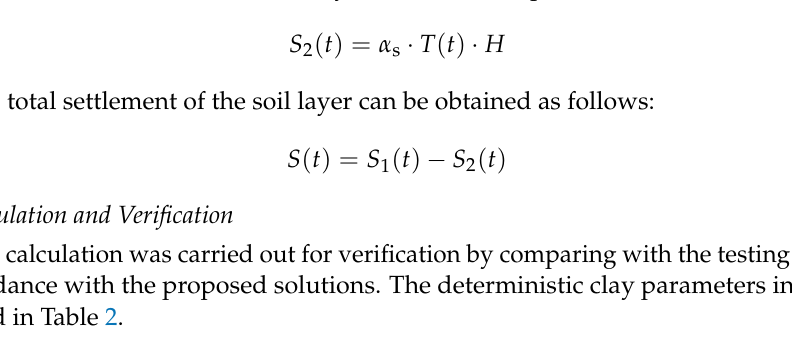
Table 2. The deterministic parameters of clay. Parameter Value Parameter Value k w